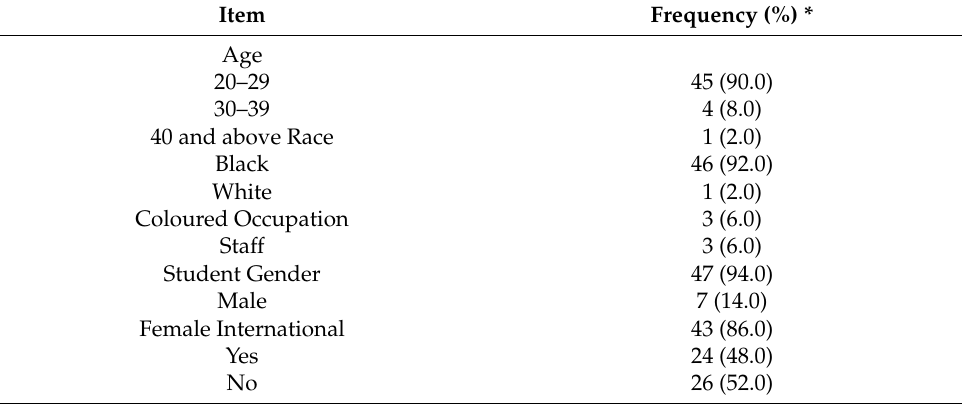
Table 8. Demography of panellist for instant egusi